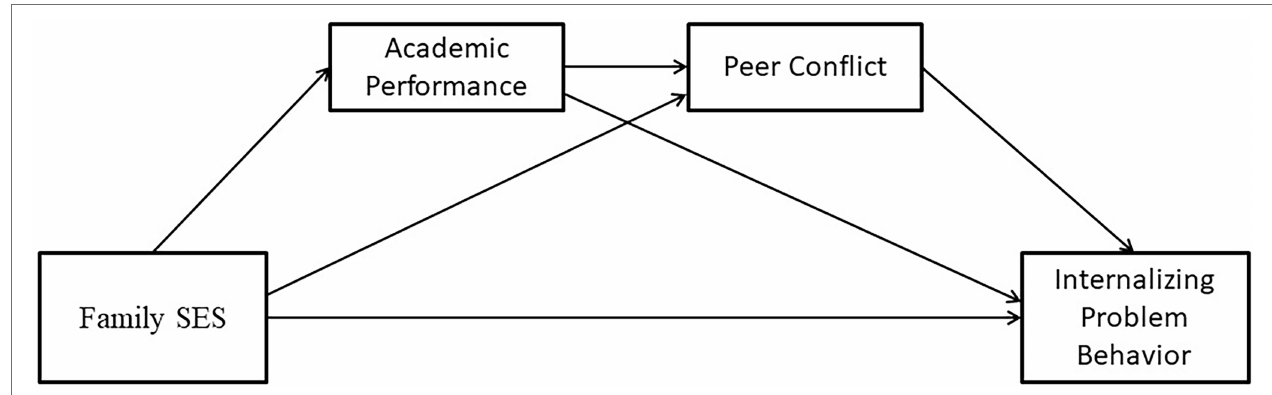
FIGURE 1 | The relationship between family socioeconomic status (SES), internalizing problem behavior (IPB), academic performance, and peer